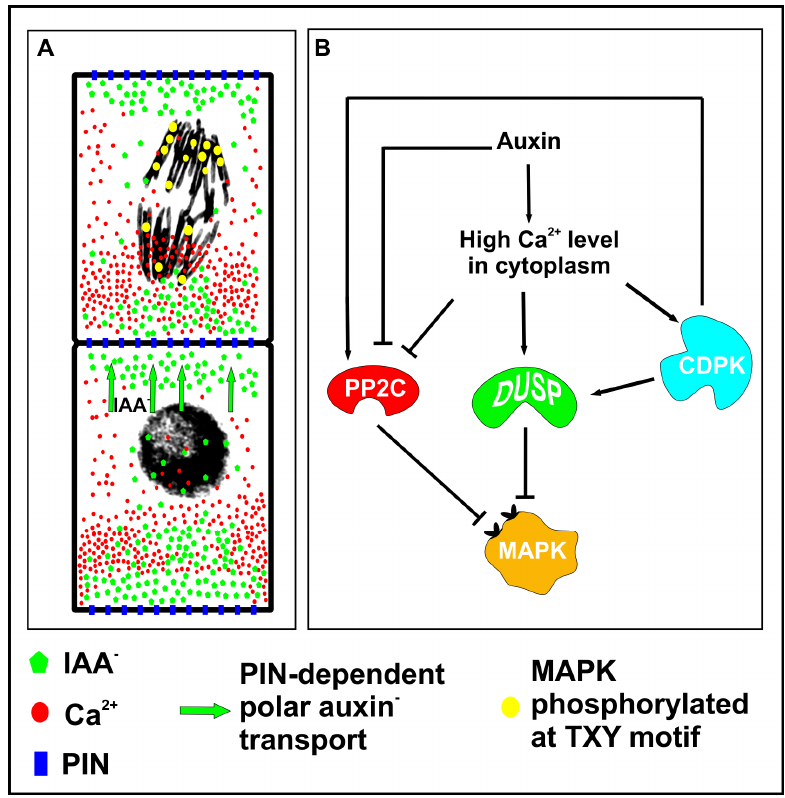
Figure 3. A hypothetical model of mitogen-activated protein kinase (MAPK)-dependent cellular patterning during embryogenesis. ( A ) The asymmetrical distribution of auxin, calcium ions and phosphorylated MAPKs in the vicinity of chromosomes. ( B ) High concentration of calcium ions at one end activates dual-specificity phosphatases (DUSPs) which dephosphorylate MAPKs and diminish the number of activated kinases in the vicinity of chromosomes. However, low calcium level at the opposite end might result in reduced activity of phosphatases, and therefore the number of chromatids with activated MAPKs might be greater at this end. Interestingly calcium ions activate CDPKs (calcium-dependent protein kinases) which may positively regulate PP2C phosphatase, however high calcium concentration was found to directly inhibit the activity of PP2C phosphatase.